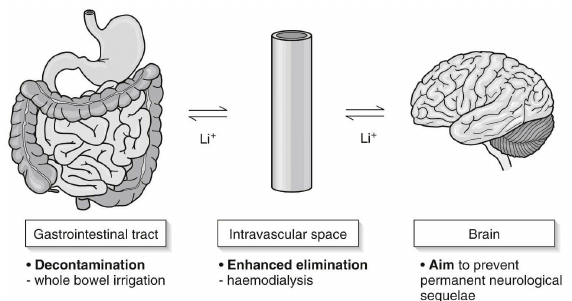
Figure 3 . Lithium - the three-compartment model of distribution